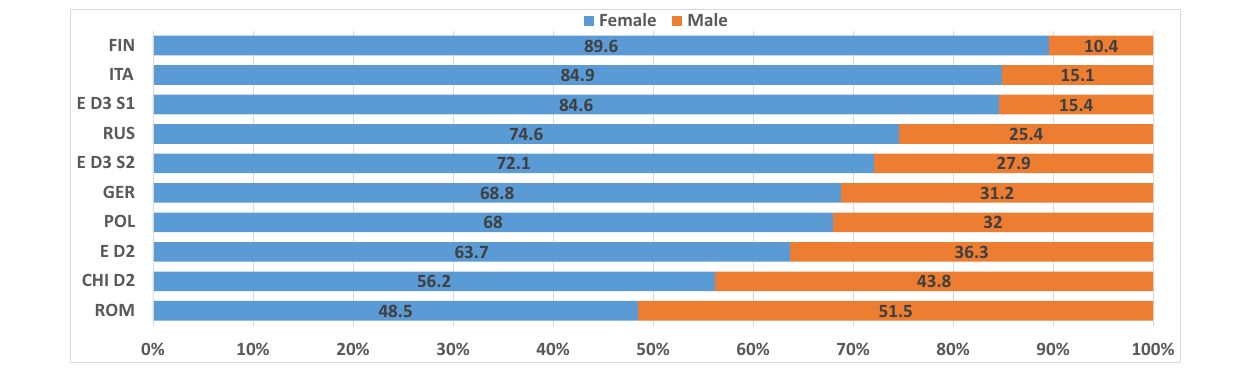
TABLE 2 | Results of Mann-Whitney testing with Bonferroni-Holm correction regarding the Accuracy. Time Dataset pair Holm’s method Frame p